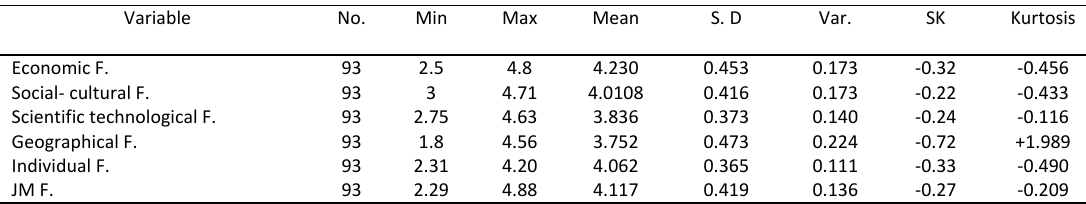
Table3: Description of research main variables